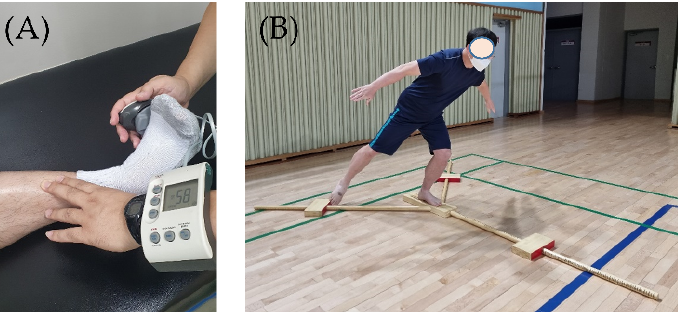
Figure 3. Ankle strength and dynamic balance test; ( A ) Hand-held dynamometer strength test; ( B ) Y-balance test.